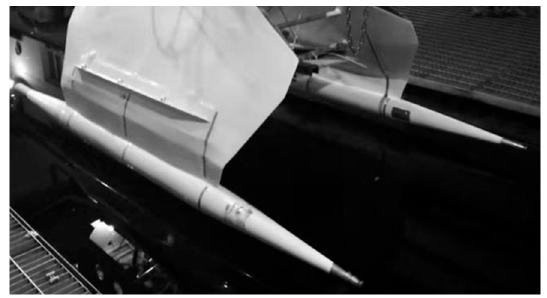
Figure 4. Experimental setup for model tests.